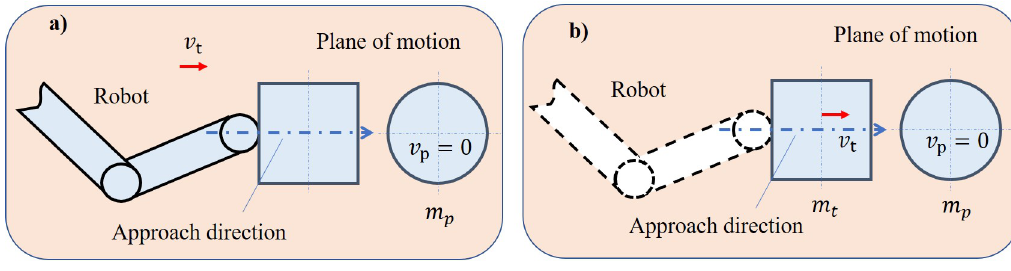
Figure 1. Instantaneous impacts. ( a ) A tool rigidly fixed to the robot; ( b ) a tool decoupled from the